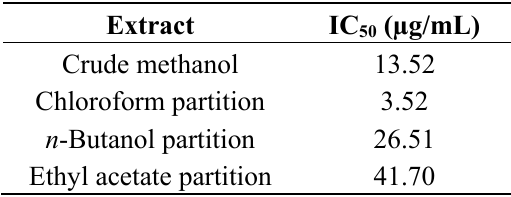
values of the extracts of leaves of C. lucidus. Table 3. IC 50